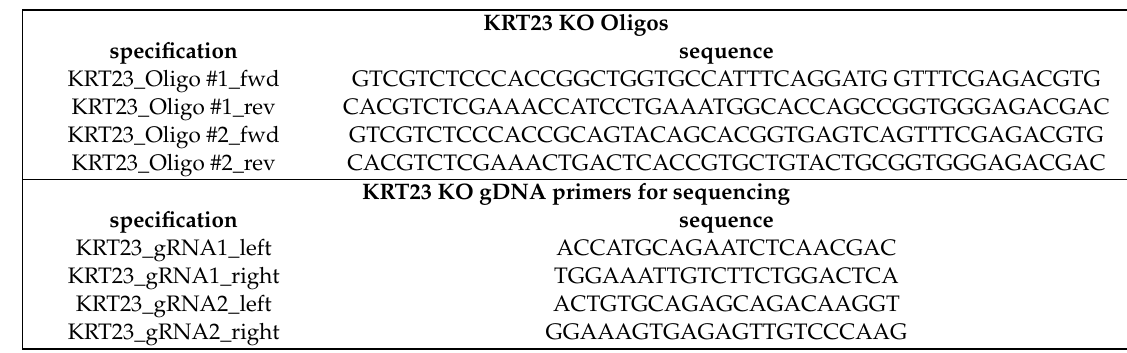
Table A1. Sequences of the oligonucleotides used for the single-guide RNA (sgRNA) vector cloning and for the sequencing of the genomic DNA (gDNA) of the CRISPR / Cas 9 KO cell